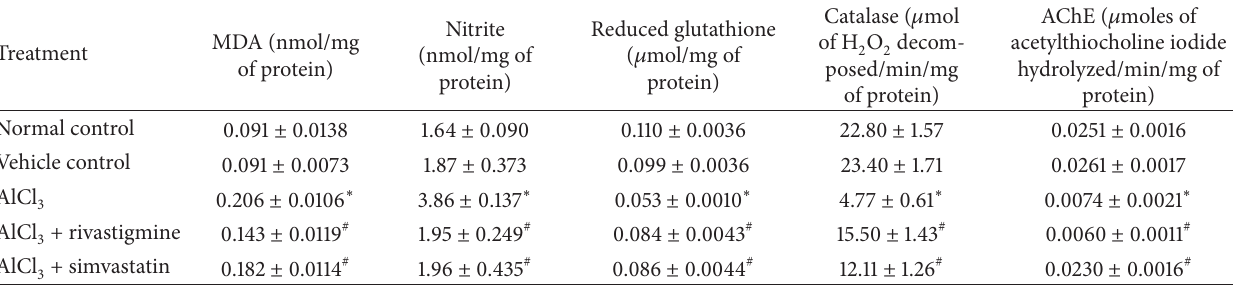
Table 3: Effect of simvastatin on AlCl